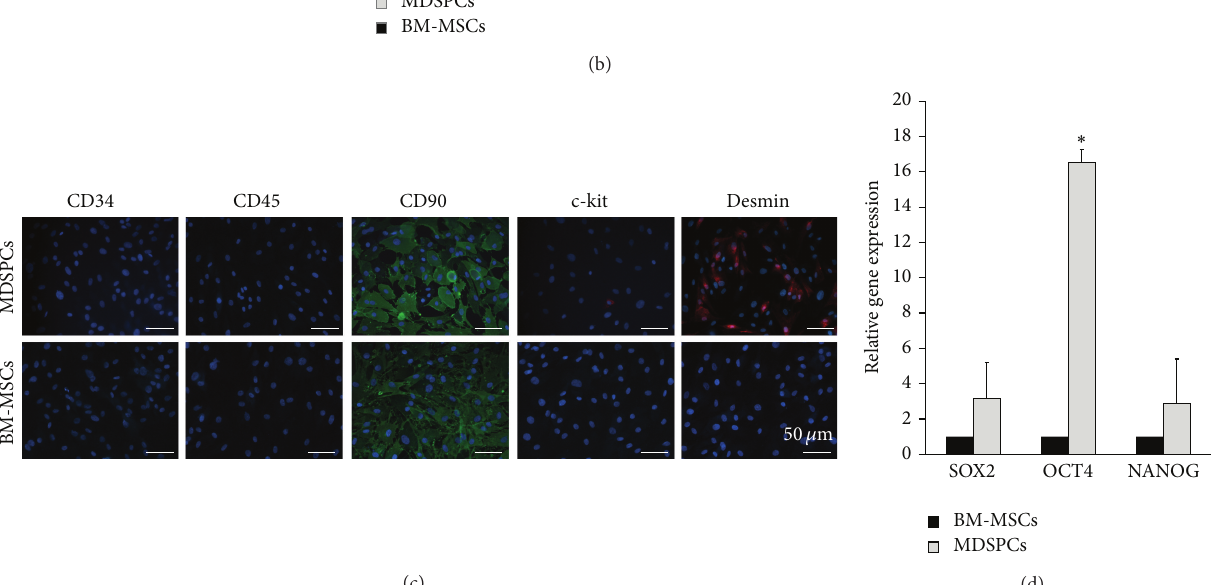
Figure 3: Surface marker and gene expression analysis of MDSPCs and BM-MSCs at passages 4-5. Surface marker expression was determined by the flow cytometry ((a), (b)) and immunofluorescence staining (c). BM-MSCs and MDSPCs highly expressed CD90 and CD59 and were negative ( < 1%) for CD45 and CD34. MDSPCs were positive for desmin and weakly positive for c-kit (CD117), while BM-MSCs were negative for both of these markers. (d) MDSPCs had higher expression of SOX2, OCT4, and NANOG, but the significant difference was detected only in OCT4 expression ( 𝑝 = 0.037 ). ∗ 𝑝 < 0.05 , significant